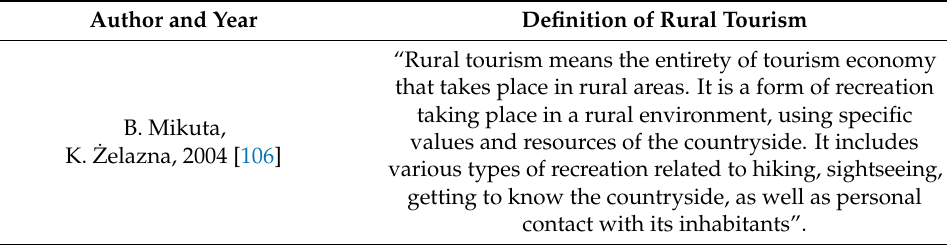
Table 5. Definitions of rural tourism in Polish